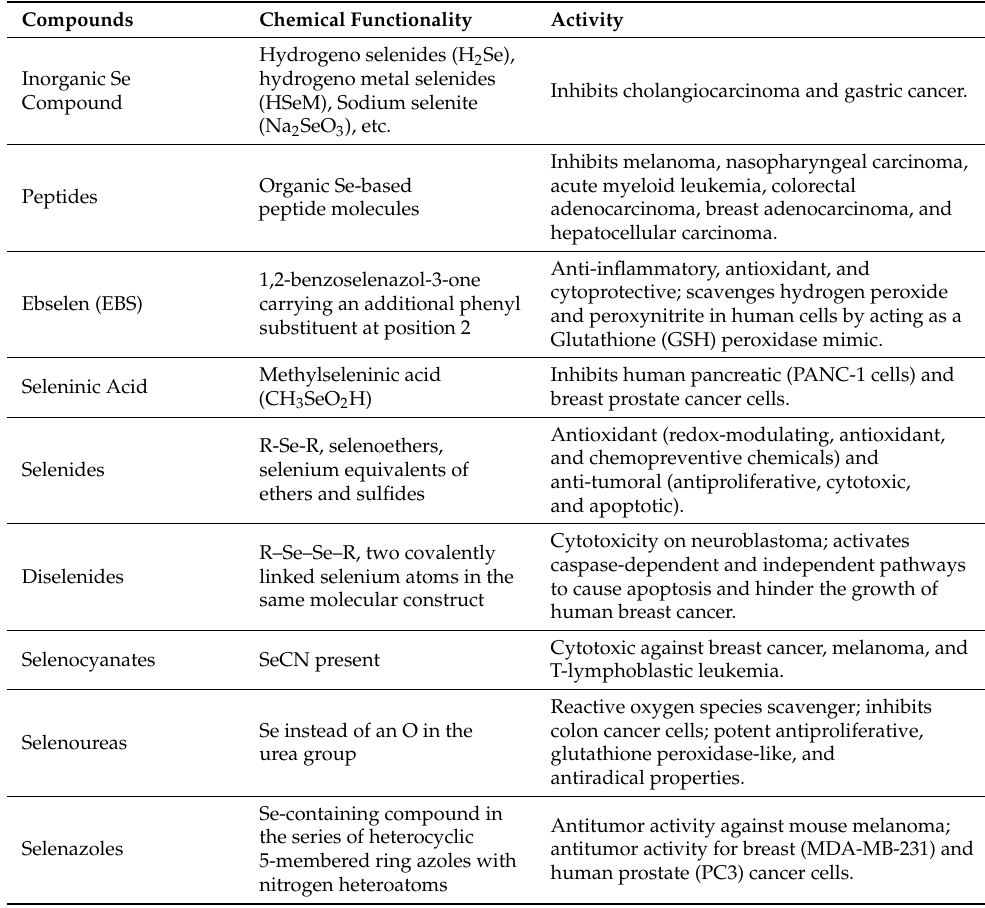
Table 1. Category of selenium-containing compounds with anticancer